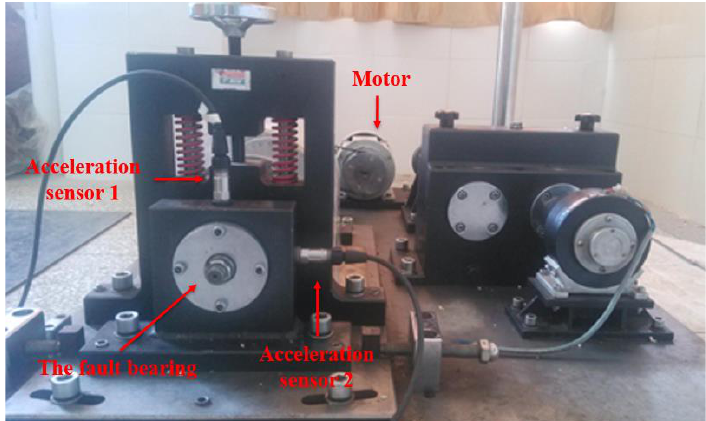
Figure 10. The test bench and microphone arrangement.